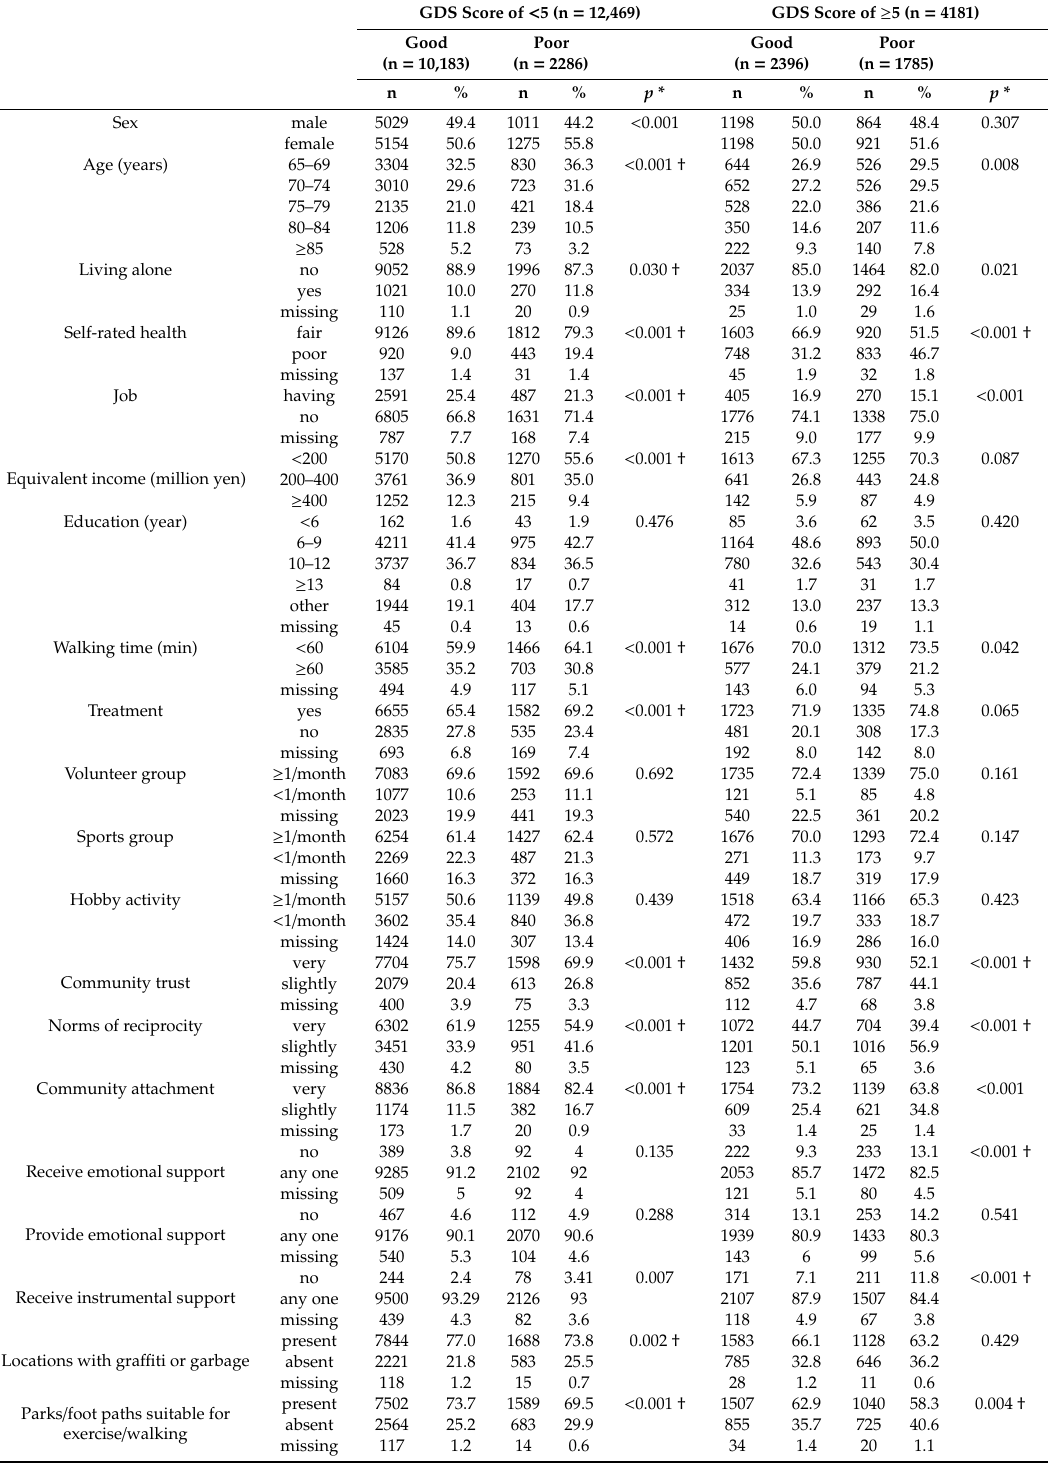
Table 2. Characteristics of participants divided by depressive status (GDS score of ≥ 5 or < 5) and sleep quality (good or